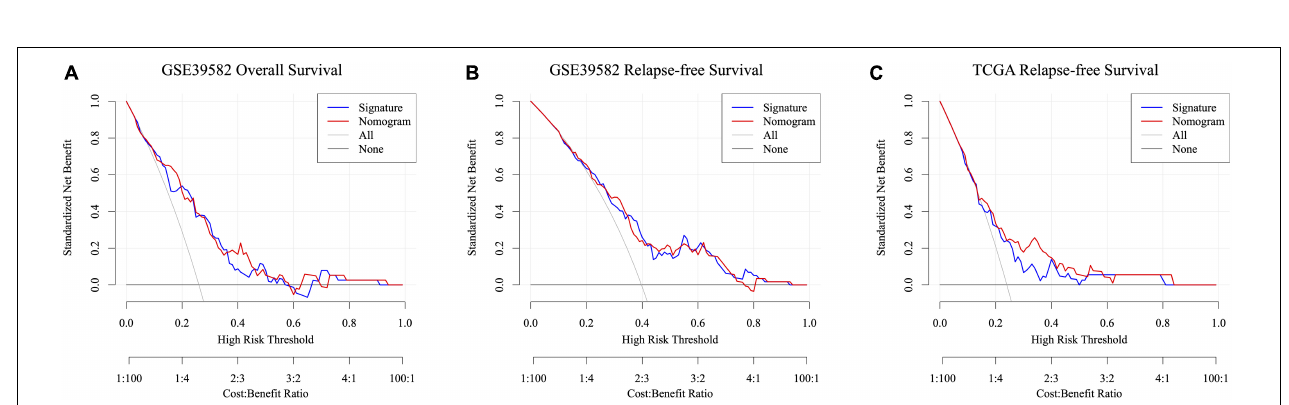
FIGURE 8 | Decision curve analysis of the nomogram and signature for predicting ACT-response of stage III CRC patients in the GSE39582 RFS cohort (A) , GSE39582 OS cohorts (B) , and TCGA RFS cohorts (C) . The gray line and black line represent the assumption regarding all patients with and without risk stratification, respectively. The red line represents the nomogram, and the blue line represents the signature.